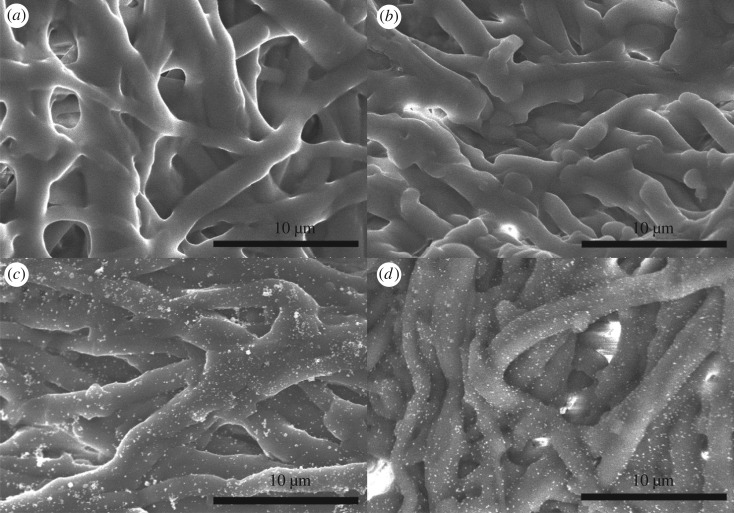
SEM images of natural ESM (a), MESM (b), Cu2+–Ag+ /MESM (c) and Cu–Ag/MESM (d).